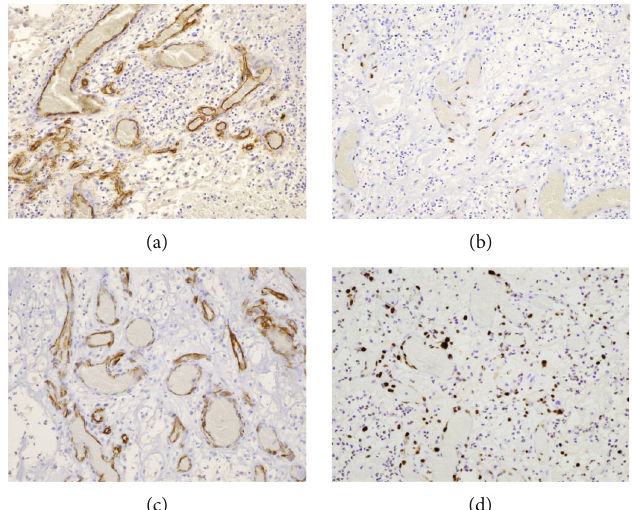
Figure 6: Immunohistochemical staining. The endothelial cells are positive for CD34 (a), ERG (b), and WT-1 (c) (each original magni fi cation × 100). Approximately 5% of the endothelial cells are positive for Ki-67 (d) (original magni fi cation ×